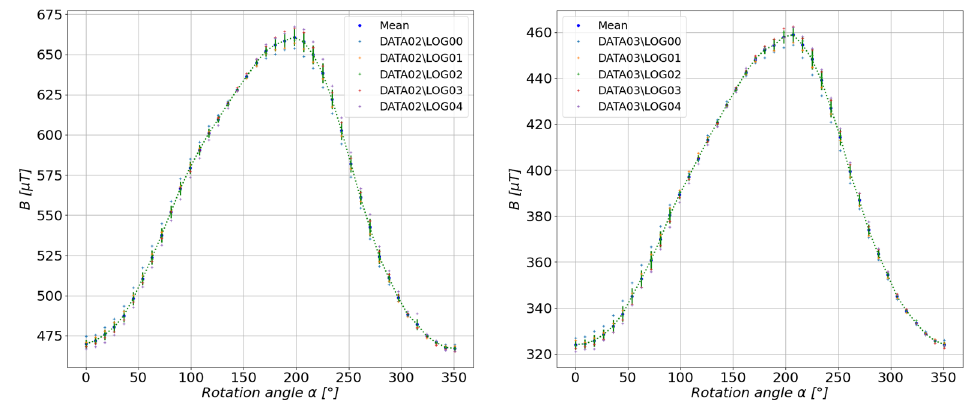
Figure 11. Measurement results at a distance of 6 cm ( left ) and 7 cm ( right ) from the center of the tested configuration.